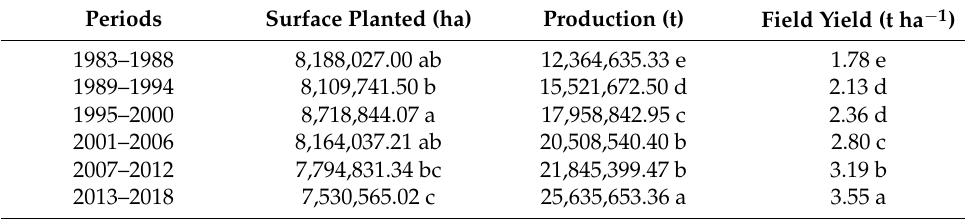
Table 4. Tukey’s means test for field indicators of grain maize production in Mexico, 1983–2018. Periods Surface Planted (ha)